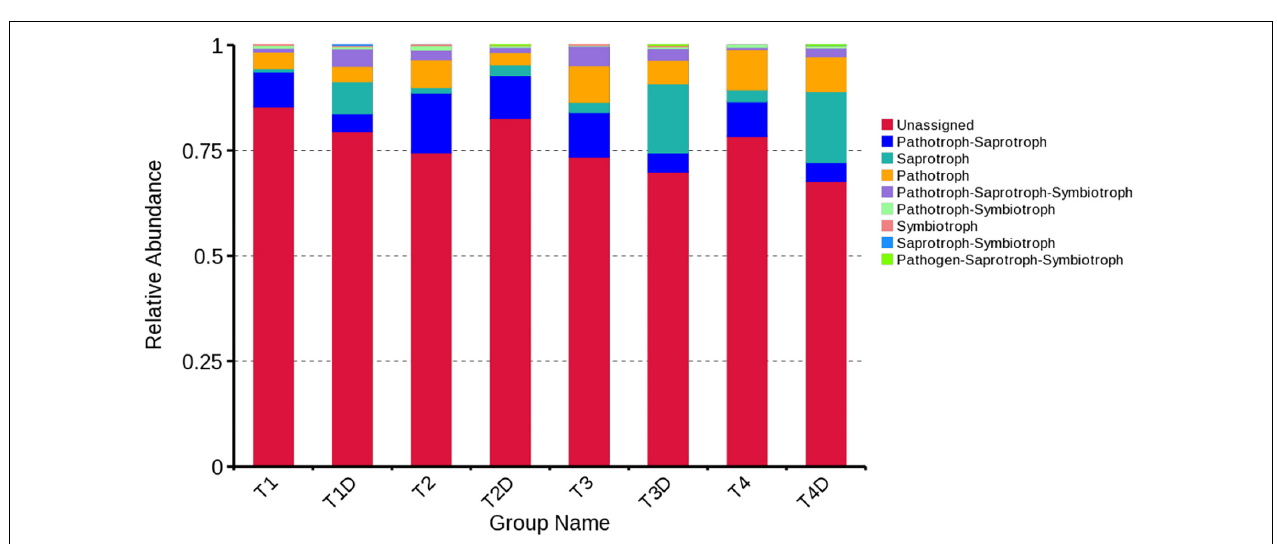
FIGURE 7 | Relative abundance of fungal functional groups (guilds) based on OTU annotation table with disturbance frequency